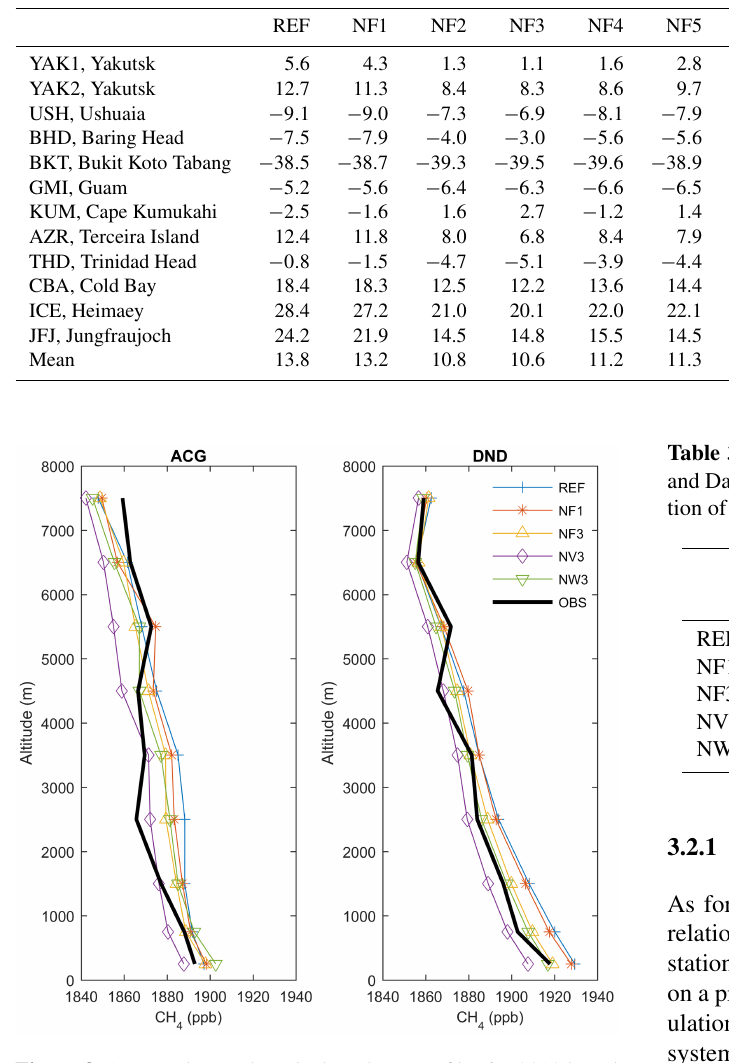
Figure 8. Averaged annual vertical methane profiles for 2013 based on monthly averaged data at NOAA profile locations ACG (Alaska Coast Guard, USA) and DND (Dahlen, North Dakota, USA). See Fig. 1 for approximate profile locations.